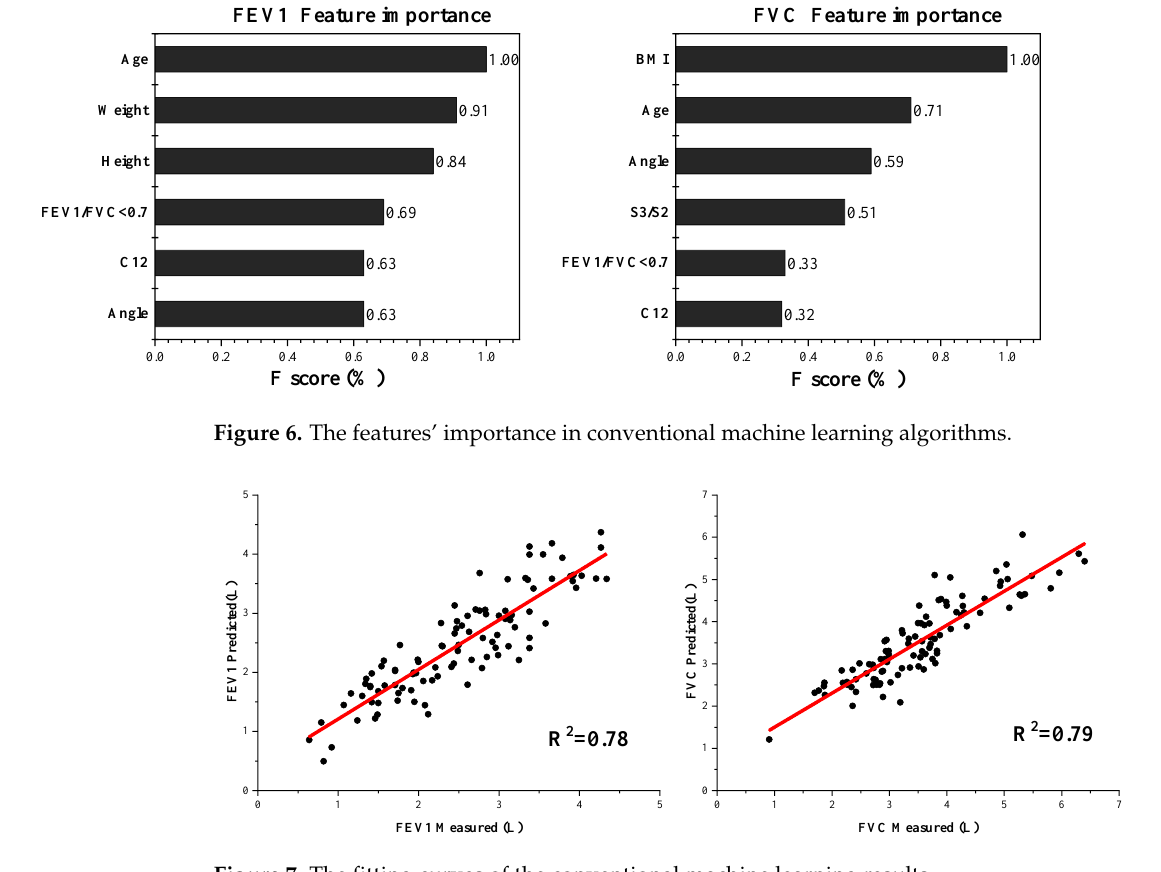
Figure 7. The fitting curves of the conventional machine learning results.